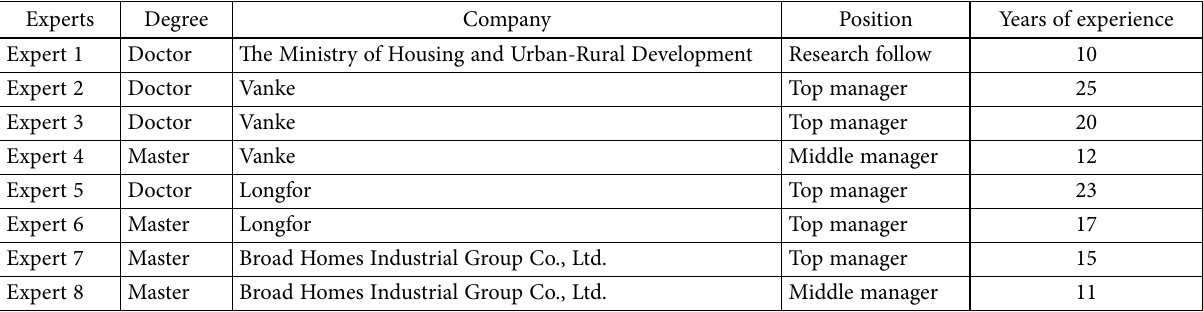
Table 1. Demographic characteristics of